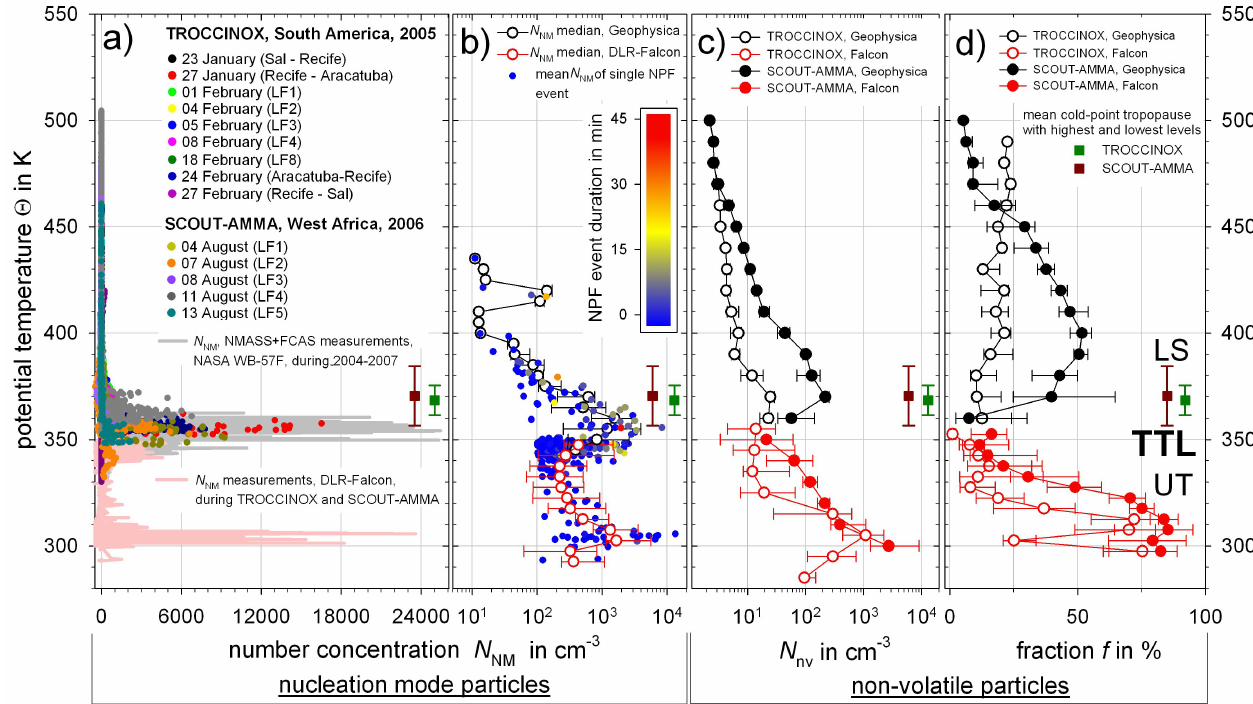
Fig. 3. (a) Colored circles: concentrations of nucleation mode particles, N NM , in the size range 6nm <d p < 15nm (COPAS) of 9 tropical flights of the M-55 “Geophysica” during TROCCINOX (4 transfer and 5 local flights) and of 5 local flights during SCOUT-AMMA. Rose colored: N NM (4nm <d p < 15nm) from CPC measurements on the DLR Falcon-20 throughout both campaigns ( 2< 350K). Grey colored: N NM (5.3nm <d p < 15nm) resulting from 4yr of measurements with the NMASS system (on the NASA WB-57F). (b) Solid lines: median vertical distribution of N NM with 25th and 75th percentiles from COPAS measurements (black) and DLR Falcon-20 CPC measurements (red). Circles: averaged N NM of single NPF events, color-coded according to the observed event duration. (c) Median vertical profile with 25th and 75th percentiles of the number concentration ( N nv ) of non-volatile particles with d p > 1,0nm. (d) Median vertical profile with 25th and 75th percentiles of the fraction f = N nv / N 6 of non-volatile particles (black: COPAS measurements; red: DLR Falcon -20 CPC data). Squares with vertical bars: mean cold point tropopause (green: TROCCINOX; dark-red: SCOUT-AMMA) with bars denoting the highest and lowest encountered tropopause